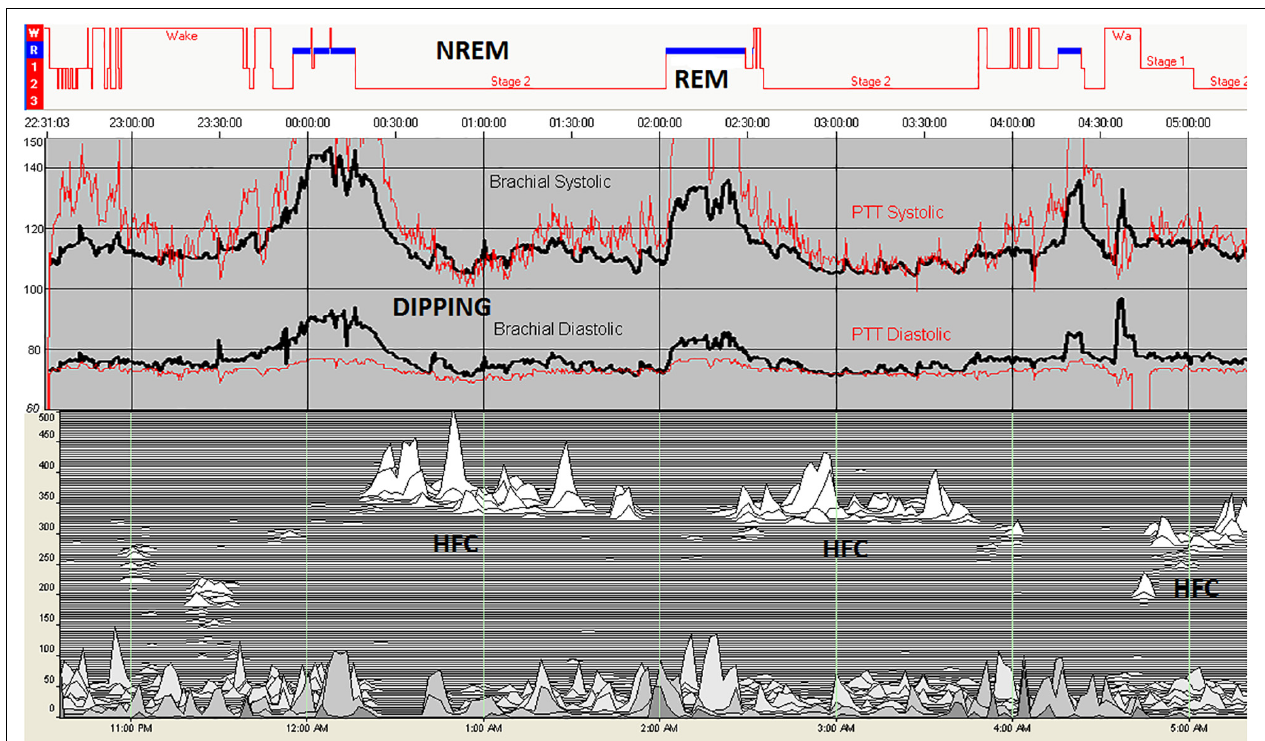
FIGURE 4 | Blood pressure in relation to sleep stage and state. Intra-arterial (black) and PTT-derived (red) blood pressure during polysomnography shows a rise during REM sleep and reductions during periods of high frequency coupling during stage N2. In this individual, there is no N3 sleep, demonstrating the independence of high frequency coupling from conventional slow wave sleep. REM sleep results in an increase in blood pressure. The drop of blood pressure in the initial wake periods reflected the effect of quiet/relaxed state on cardiovascular hemodynamics. HFC, high frequency coupling periods; NREM, non-rapid eye movement; and REM, rapid eye